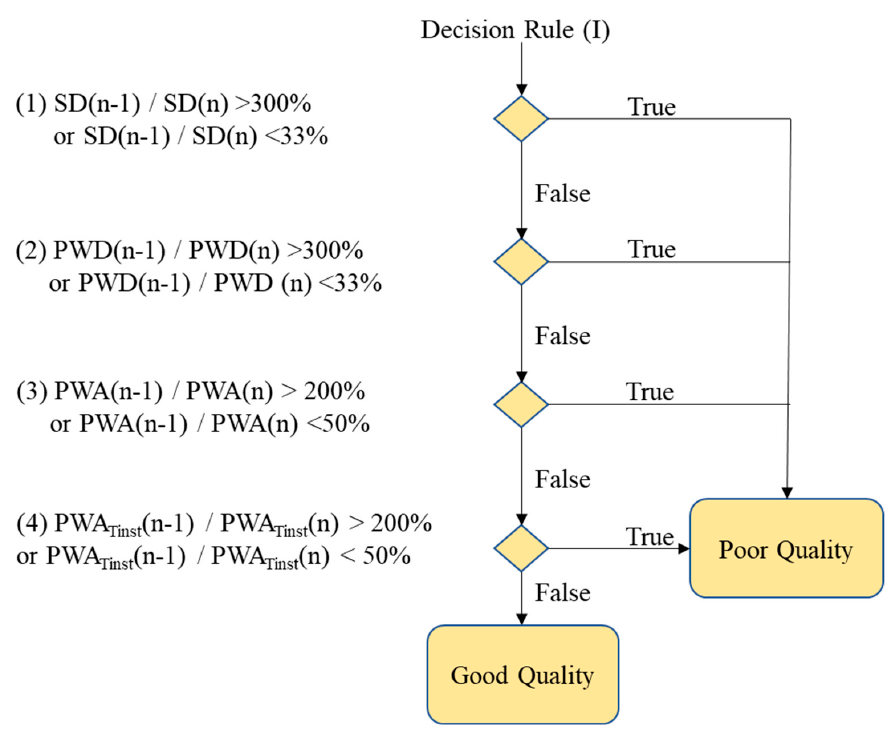
Figure 6. The decision rule (II). If any one rule is true, the pulse is poor quality.